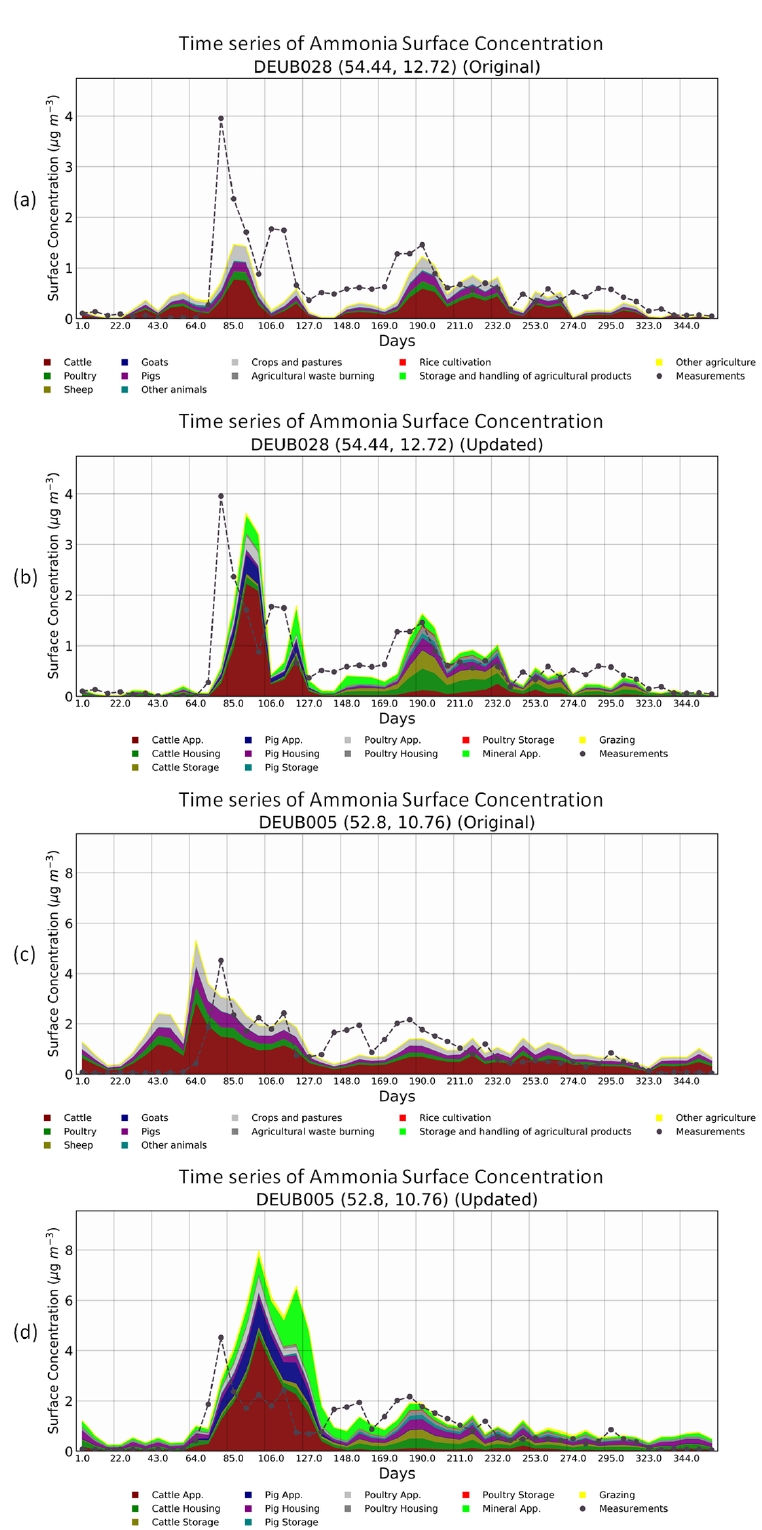
Figure 8. Comparison of surface concentration measurements within the EMEP network and simulated surface concentrations from original and updated modeled annual emission and time profiles: (a) in situ measurements vs. the original modeled output at station DEUB028; (b) in situ measurements vs. the updated modeled output at station DEUB028; (c) in situ measurements vs. the original modeled output at station DEUB005; (d) in situ measurements vs. the updated modeled output at station